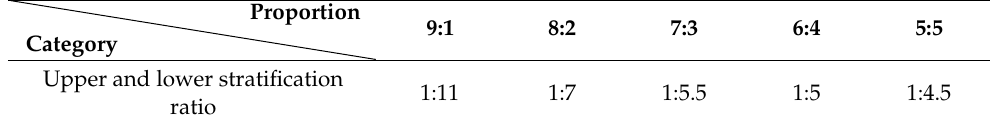
Table 6. Delamination ratio of AEP-DPA composite system after